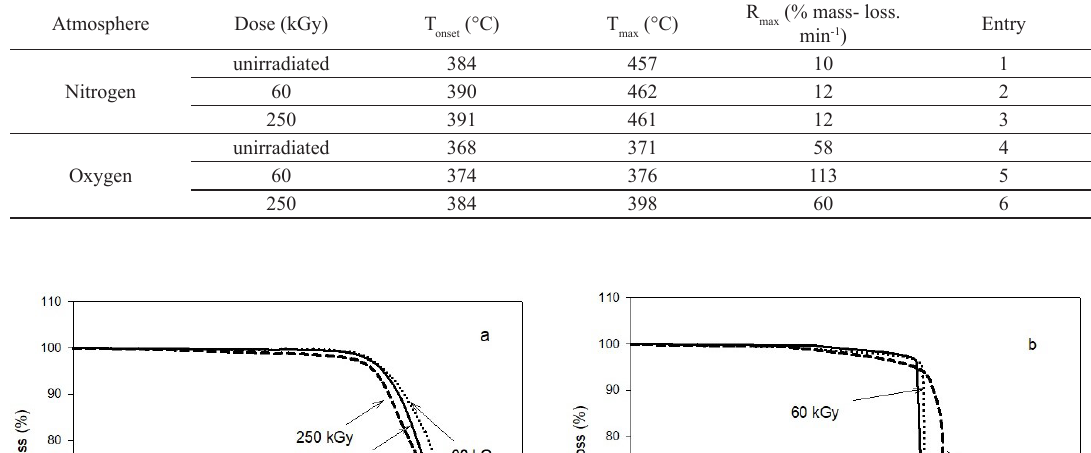
Table 2. Thermal degradation parameters of unirradiated or gamma-irradiated LLDPE at 60 kGy or 250 kGy dose in O Heating rate of 10 °C.min -1 .